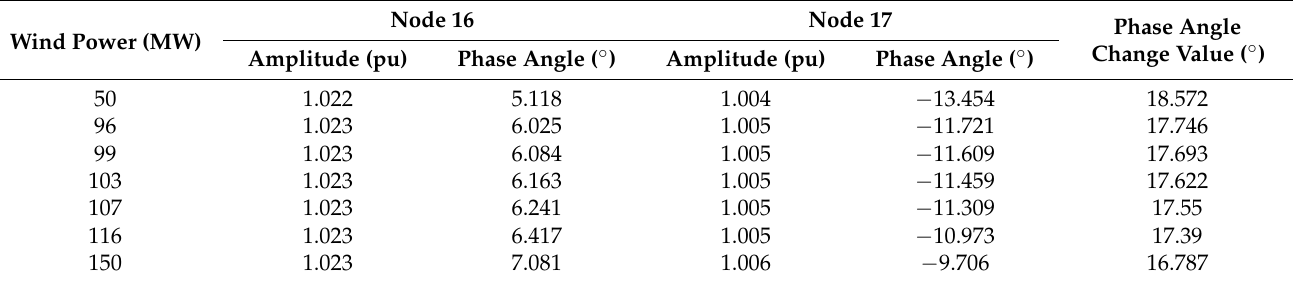
Table 8. Voltage values of nodes 16 and 17 under different wind-power output scenarios.